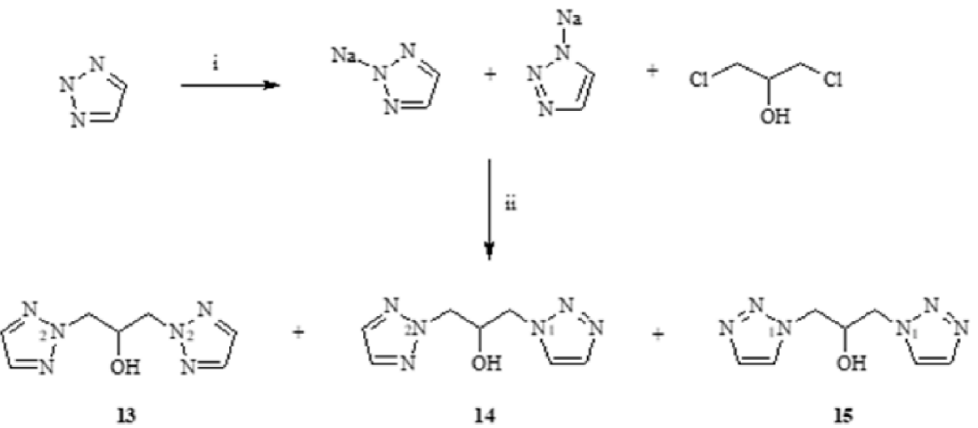
Figure 6. Scheme of synthesis of alcohols 13–15 . i—Na, MeOH 1,3- dichloroacetone; ii—acetonitrile, reflux.